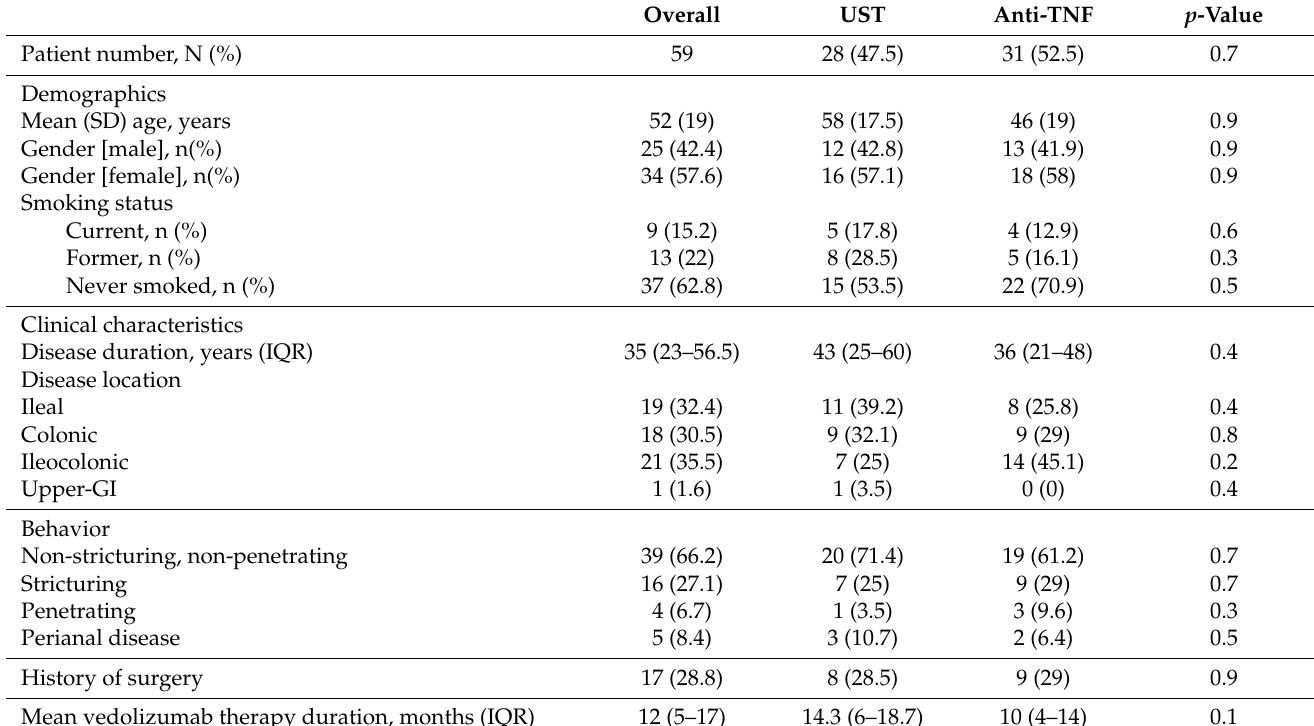
Table 1. Patients’ demographic and clinical